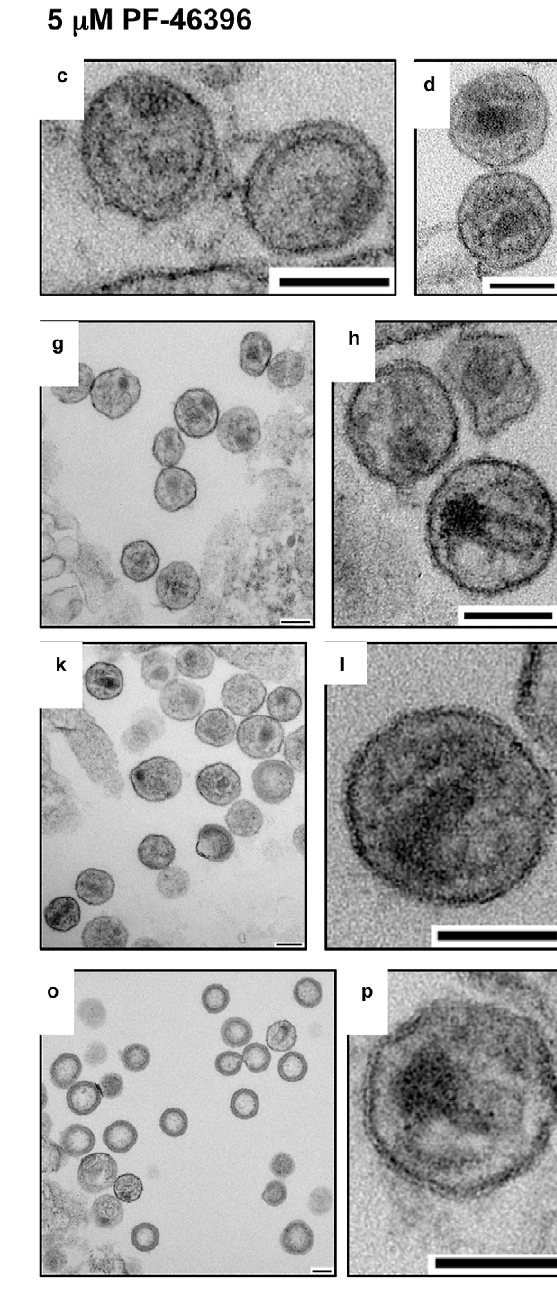
Figure 7. EM analysis of 293T cells transfected with WT pNL4-3 or the indicated mutant derivatives and treated without (no inhibitor) or with 5 m M PF-46396. Note highly defective EM morphology and accumulation of Gag at the plasma membrane for the mutants in the absence of PF-46396, and the rescue of assembly/release in the presence of compound. Scale bars: a–d, f–h, j–p=100 nm; e, i=500 nm.